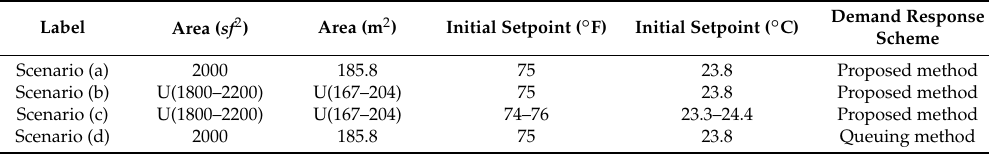
Table 3. The specific parameters of the three scenarios.